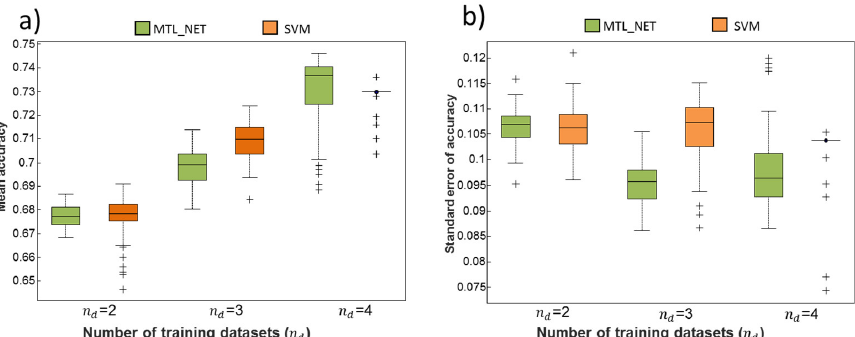
Figure 2. Distribution of classification accuracies and their standard errors across different numbers of training datasets. The Figure shows the mean ( a ) and standard error ( b ) of classification accuracies obtained for different numbers of training datasets ( n d ). Performance was evaluated from the test datasets not used for training. The variation of the boxplot was due to the sampling variability during